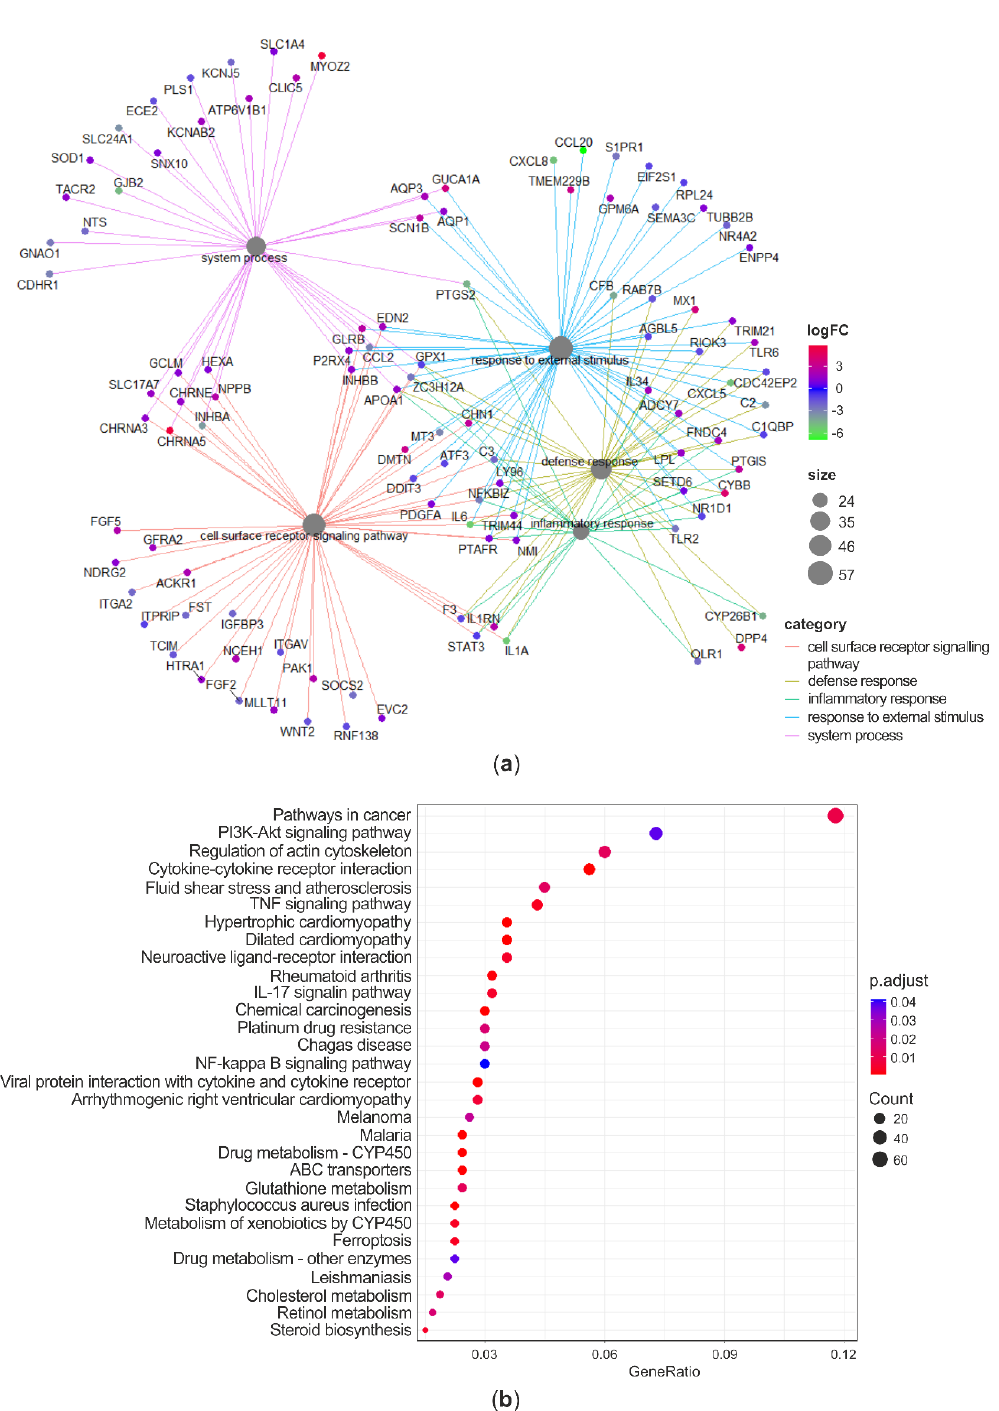
Figure 6. Gene ontology analysis: C + AFB1 vs. AFB1. Gene-concept network linking DEGs and enriched BP terms ( a ). Dotplot reporting the over-represented KEGG pathways in the list of DEGs between C + AFB1 and AFB1 ( b ). ‘Count’ is the number of genes enriched in a KEGG pathway. ‘Gene ratio’ is the percentage of total DEGs in the given pathway. p -values were adjusted using the Benjamini–Hochberg